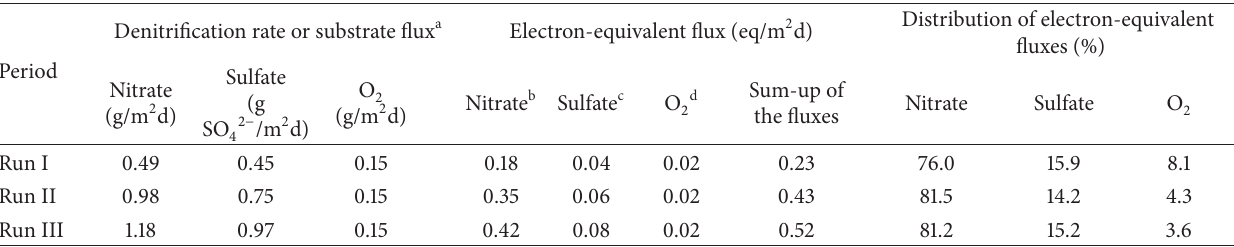
Table 3: Electronic-equivalent fluxes for sulfate and nitrate.